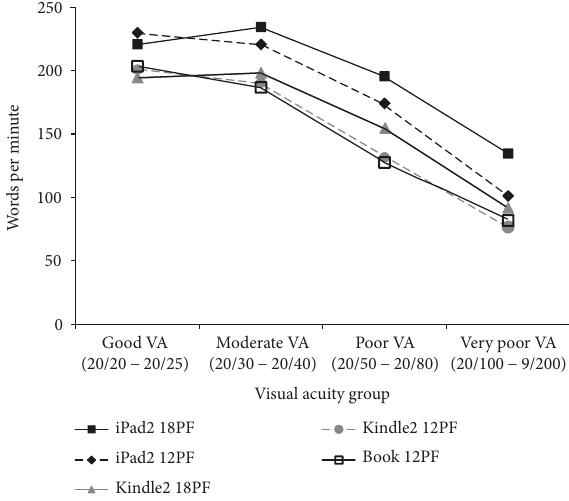
Figure 1: Reading speed strati fi ed by the visual acuity group and reading medium. Mean reading speed in words per minute (WPM) for each reading medium at 12-point font (12PF) or 18- point font (18PF), strati fi ed by the visual acuity (VA)